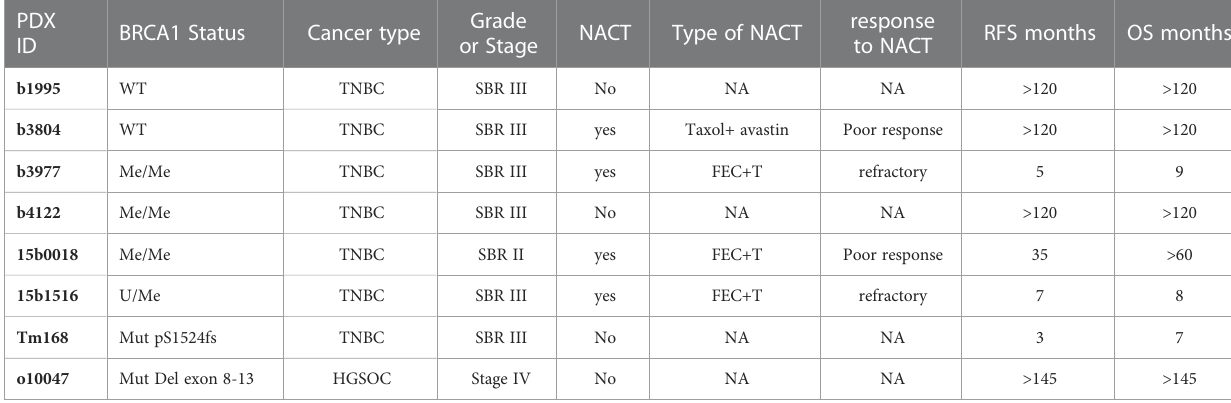
TABLE 1 Principal bio-clinical characteristics of the patient tumors from which the PDX models were